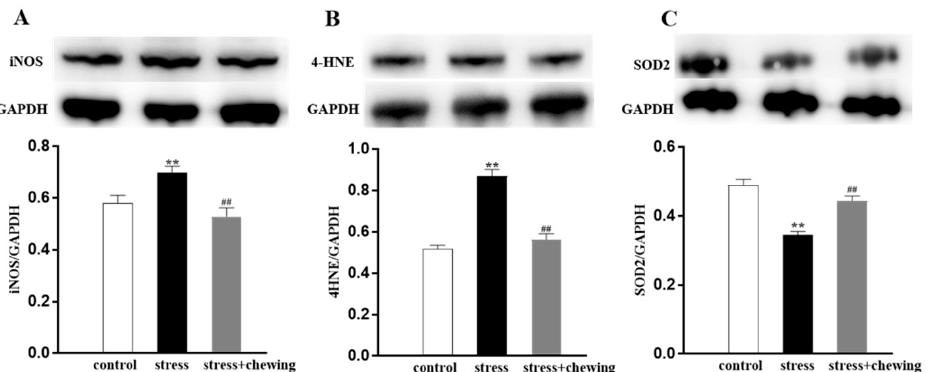
Figure 5. Chewing behavior during psychological stress improved oxidative stress in the tumor. ( A ) The expression level of iNOS protein in the tumor. ( B ) The expression level of 4HNE protein in the tumor. ( C ) The expression level of SOD2 protein in the tumor (** p < 0.01 vs. control group, ## p < 0.01 vs. stress group, n = 9/group). All data are expressed as mean ± SEM.